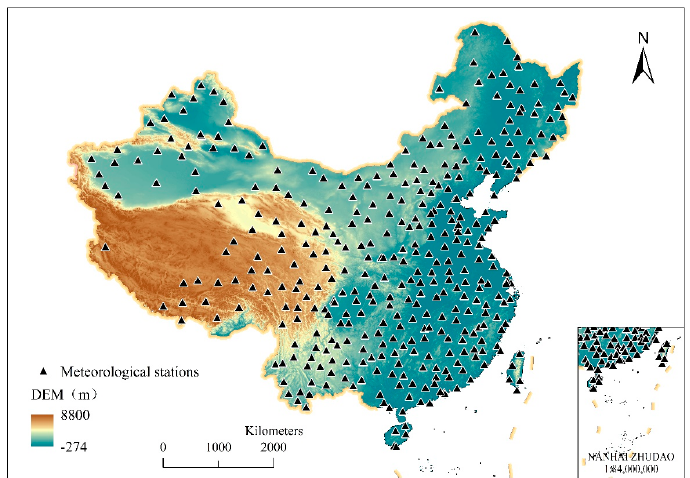
Figure 1. Distribution of the surface meteorological stations in China on the ASTER Global Digital Elevation Map (GDEM).